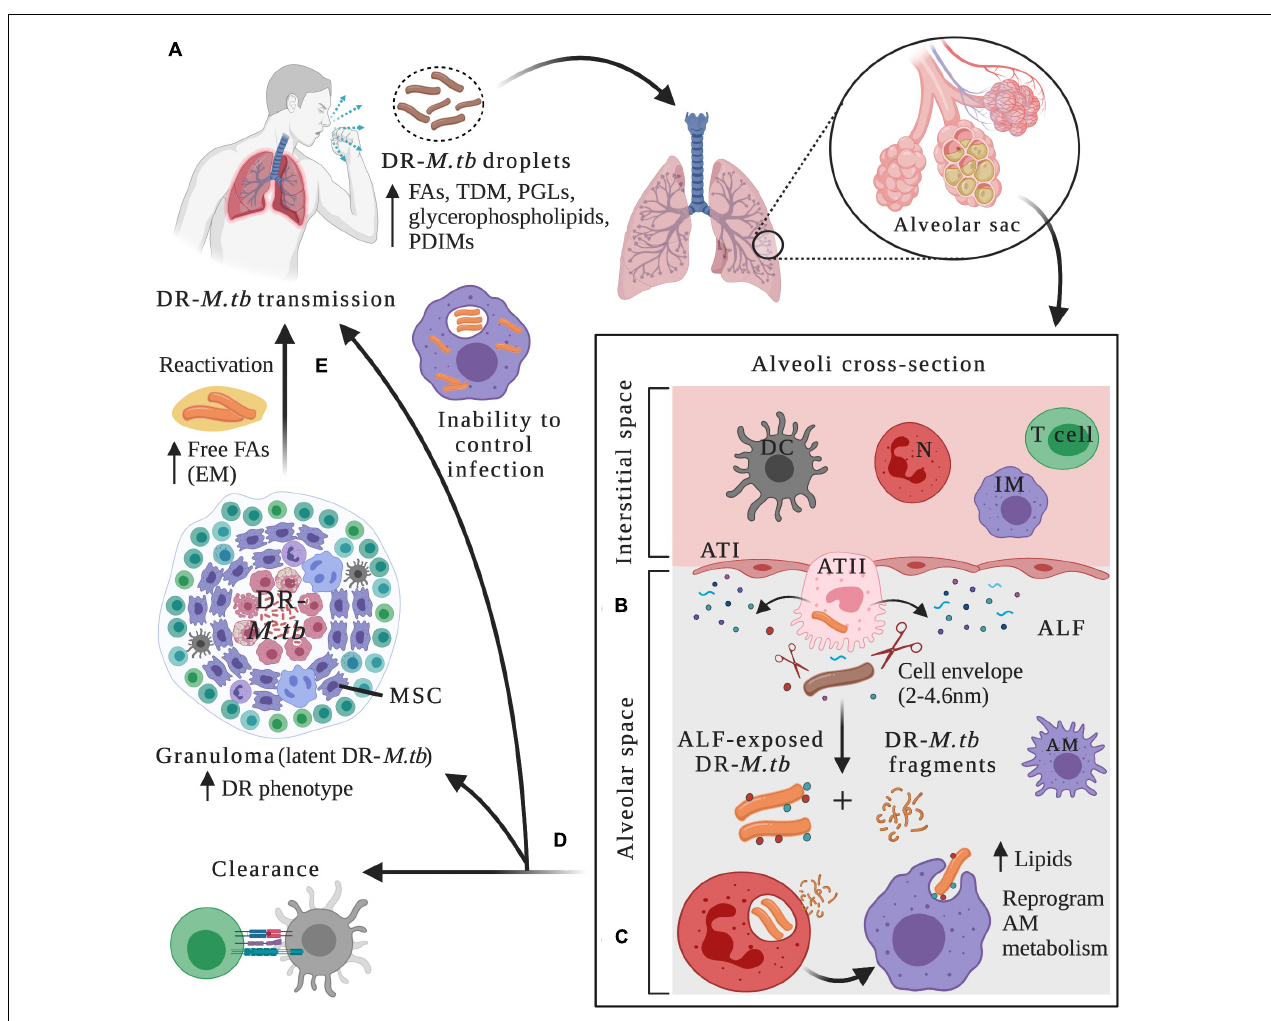
FIGURE 1 | Drug-resistant M.tb –host interactions within lung microenvironments at different stages of the infection. (A) After being in close contact with an individual with active TB disease, infection can be initiated through inhalation of drug-resistant (DR) M.tb -containing droplets. DR- M.tb bacilli contain altered levels of cell envelope lipids such as free fatty acids (FAs), trehalose dimycolate (TDM), Phthiocerol dimycocerosates (PDIMs), phenolic glycolipids (PGLs) and glycerophospholipids, among others. Upon bypassing upper respiratory tract barriers, DR- M.tb will ultimately reach the alveoli, a sac-like structure composed of a thin layer of alveolar epithelial cells type I (ATIs, with structural and gas exchange function) and alveolar epithelial cells type II (ATII, with secretor function) surrounded by capillaries. Alveolar macrophages (AMs) are resident phagocytes that populate the alveolar space, while the interstitial space surrounding the alveoli contains interstitial macrophages (IMs), dendritic cells (DCs), neutrophils (N), and T cells, among other host cells. (B) In the alveolar space, DR- M.tb bacilli first interact with host soluble innate components present in the alveolar lining fluid (ALF), where hydrolases (represented as scissors) can cleave and modify the M.tb cell envelope, releasing cell envelope fragments into the alveolar space. (C) Subsequently, ALF-modified DR- M.tb bacilli will interact with AMs (professional phagocytes) and/or with ATs (non-professional phagocytes), as well as with other host innate immune cells (e.g., neutrophils, DCs). Released DR- M.tb fragments are immunogenic and could attract neutrophils to the infection site driving local oxidative stress and inflammation, which could assist resident resting AMs to clear the infection. (D) The outcome of these initial interactions will resolve in ALF-exposed DR- M.tb clearance, establishment of a successful infection driving primary active TB disease, or a latent M.tb infection defined by M.tb persisters within granulomas, a niche that provide a protective environment against anti-TB drugs, thus increasing the DR- M.tb phenotype. Surrounding mesenchymal stem cells (MSCs) can also dampen immune responses and provide a protective intracellular environment for M.tb persistence. (E) Reactivation and subsequent progression to active TB disease can happen when granulomas fail to contain DR- M.tb , with extracellular DR- M.tb growth that leads to lung tissue destruction and cavity formation. It has been suggested that in this scenario, DR- M.tb secretes free fatty acids, creating some